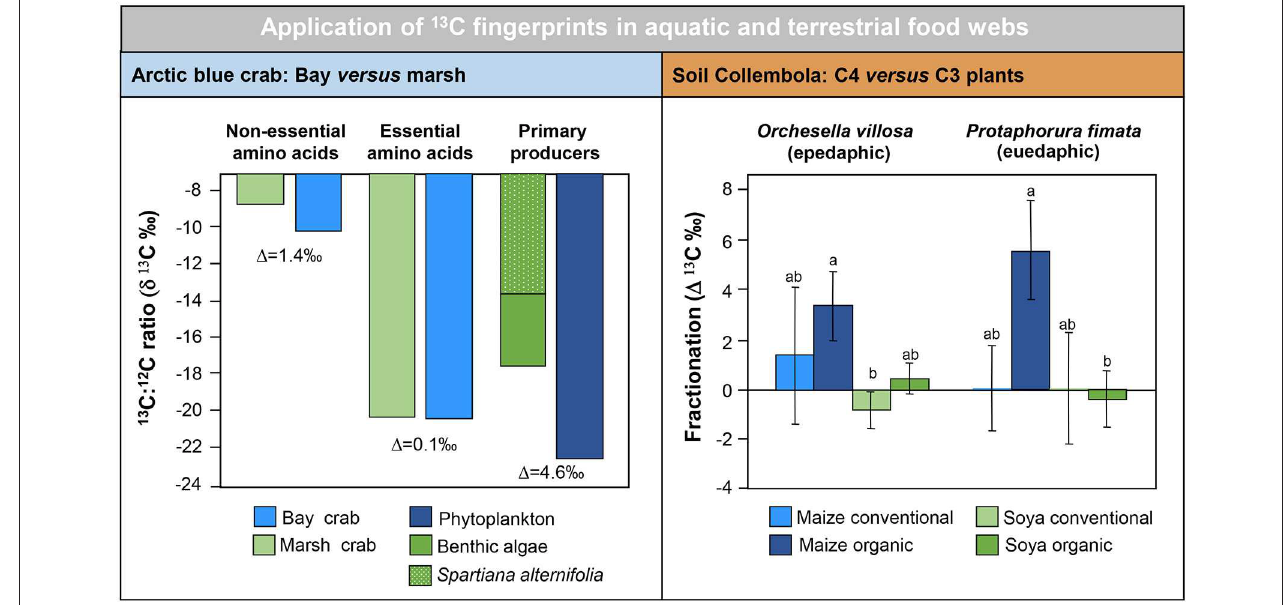
FIGURE 2 | Carbon stable isotope fingerprinting in aquatic and terrestrial food webs based on differences in δ 13 C of primary producers. Left— δ 13 C content in bulk tissue of major resources and in non-essential and essential amino acids of Atlantic blue crabs ( Callinectes sapdius ) in bay and marsh habitats (data from Fantle et al., 1999 ). The difference in δ 13 C between primary producers or amino acid fractions is expressed as 1 13 C. Right—fractionation ( 1 13 C) in linoleic acid (18:2 ω 6,9) between Collembola ( Orchesella villosa , Protaphorura fimata ) and soil fungi in a C3 (soya) and C4 (maize) arable system with different farming practice (data